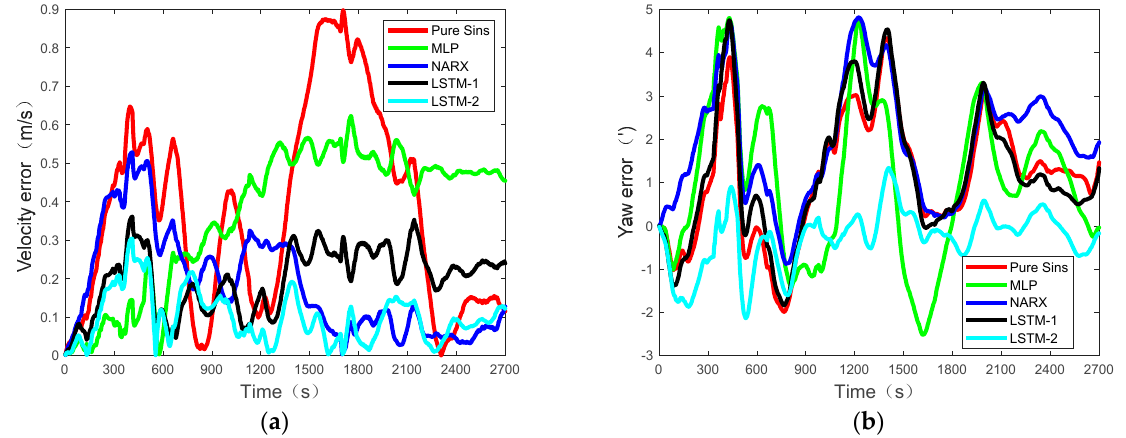
Figure 14. Comparison of navigation velocity and yaw error results: ( a ) Comparison of velocity errors.; ( b ) Comparison of yaw errors.